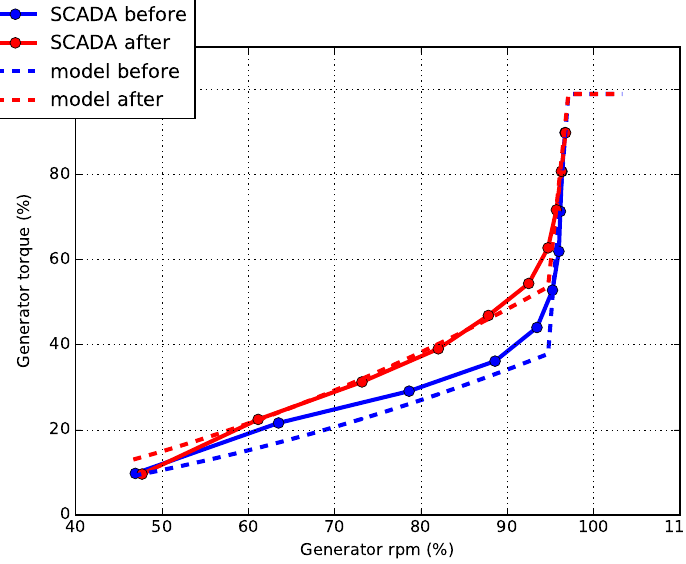
Figure 4. Numerical and experimental mechanical torque–rpm curves.